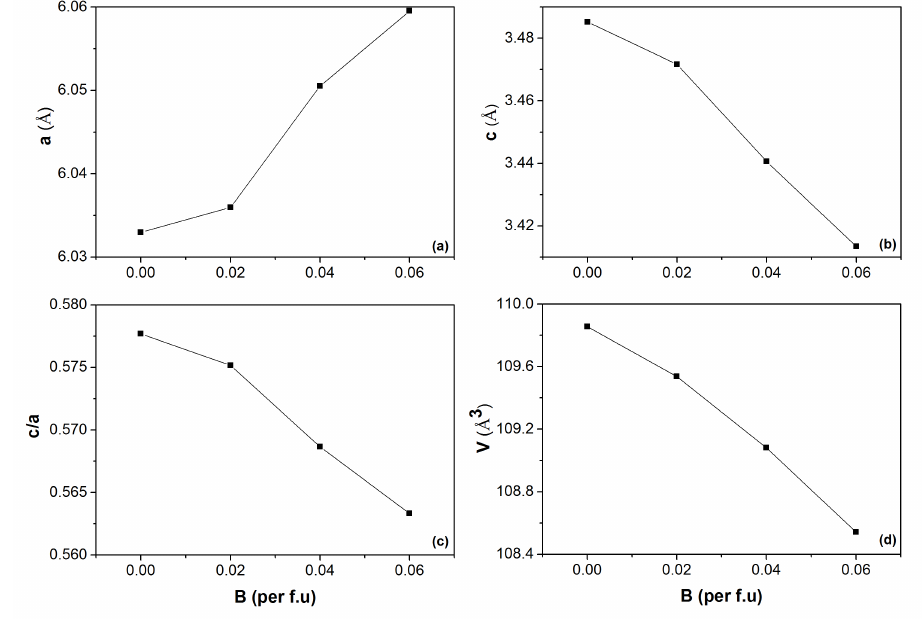
Figure 2. Lattice parameters a ( a ) and c ( b ), the c / a ratio ( c ) and the unit-cell volume V ( d ) obtained from XRD measurements at 400 K as a function of the boron content for the Mn 1.00 Fe 0.85 Co 0.10 P 0.55 − z Si 0.45 B z compounds. The temperature dependence of the magnetization ( M − T curve) measured in a magnetic field of 1 T for the Mn 1.00 Fe 0.85 Co 0.10 P 0.55 − z Si 0.45 B z series is shown in Figure 3. It is found that the